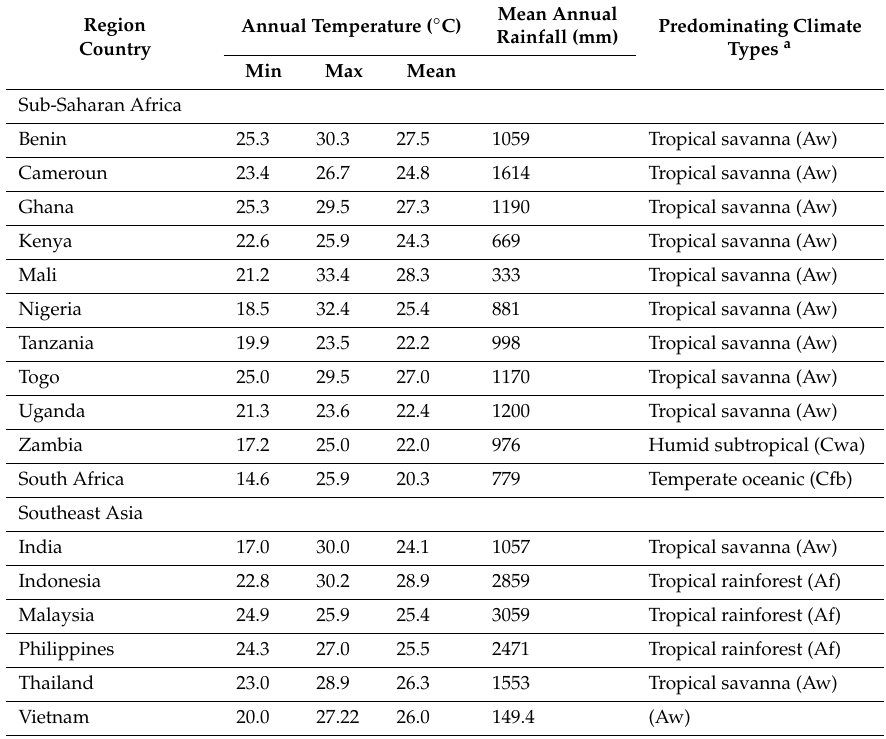
Table 3. Climatic conditions in countries reputed for their vulnerability to aflatoxin contamination. Data are mean values for the period of 1901–2016